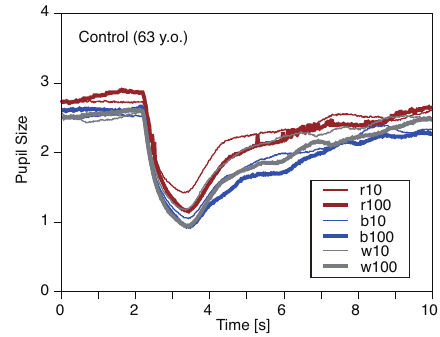
Figure 2. An example of PLRs for a control group subject